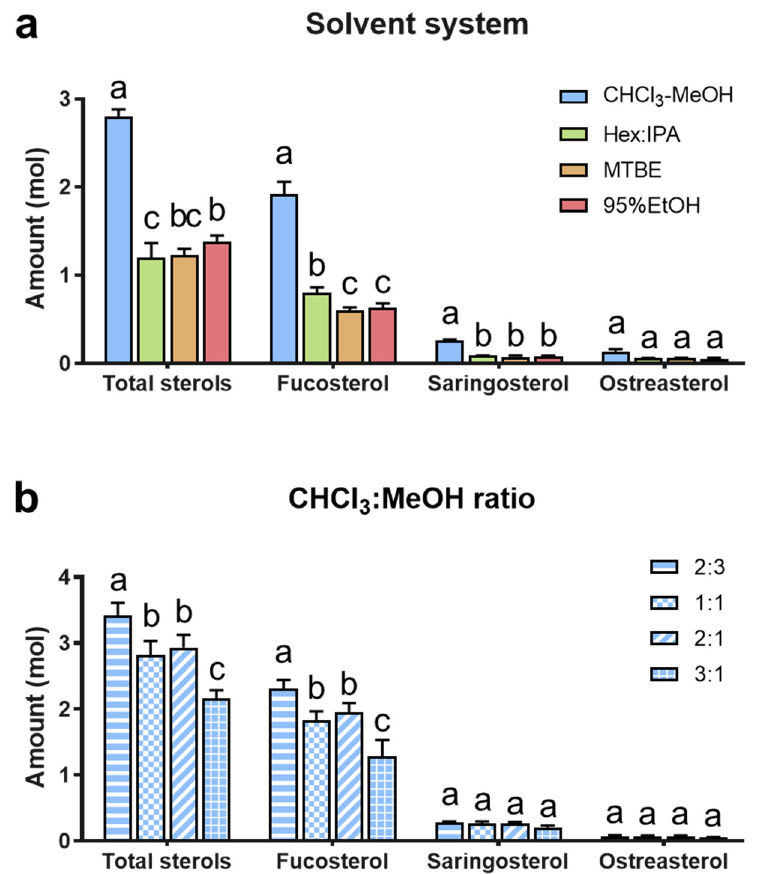
Figure 2. ( a ) Comparison of different extract solvent systems for extracting phytosterols, including chloroform/methanol (CHCl3-MeOH), hexane/2-propanol (Hex-IPA), hexane/MTBE/2-propanol (MTBE), and ethanol (EtOH). ( b ) Comparison of different chloroform-methanol ratios for extracting